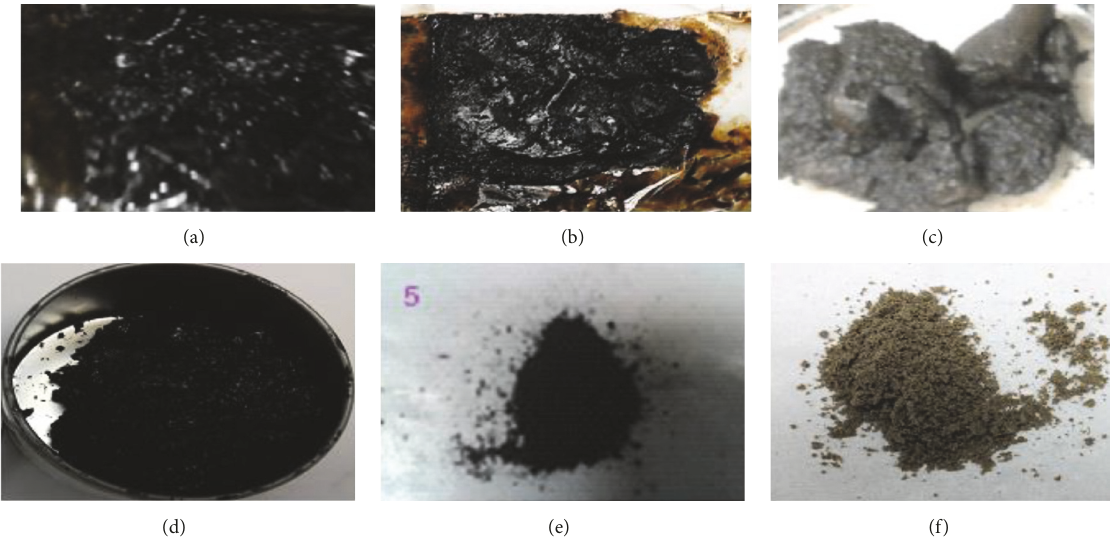
Figure 1: The schematic diagrams of the sludge samples used in this study are (a) oily sludge, (b) soft sludge, (c) water sludge, (d) dry oily sludge, (e) filter sludge, and (f) dry soft sludge.